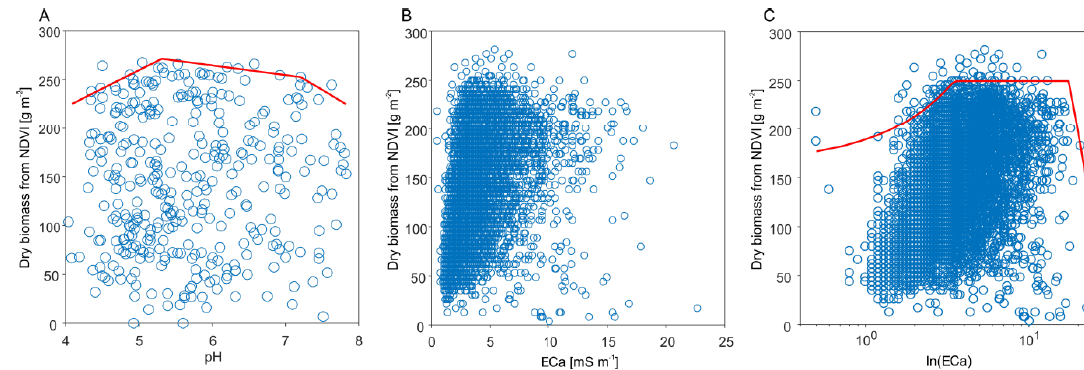
Figure 7. Association between pH, ( A ) ECa, ( B ) log-transformed ECa, ( C ) and grassland biomass of a alfalfa-grass mixture and modelling of their yield-limiting effect by means of quantile regression.